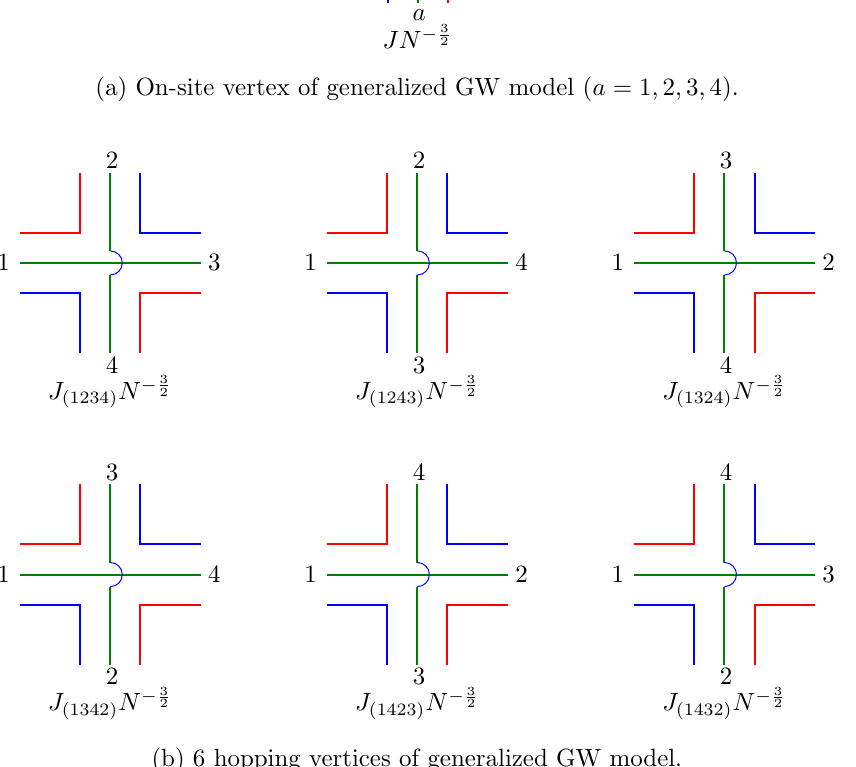
Figure 23. The Basic Vertices of generalized GW